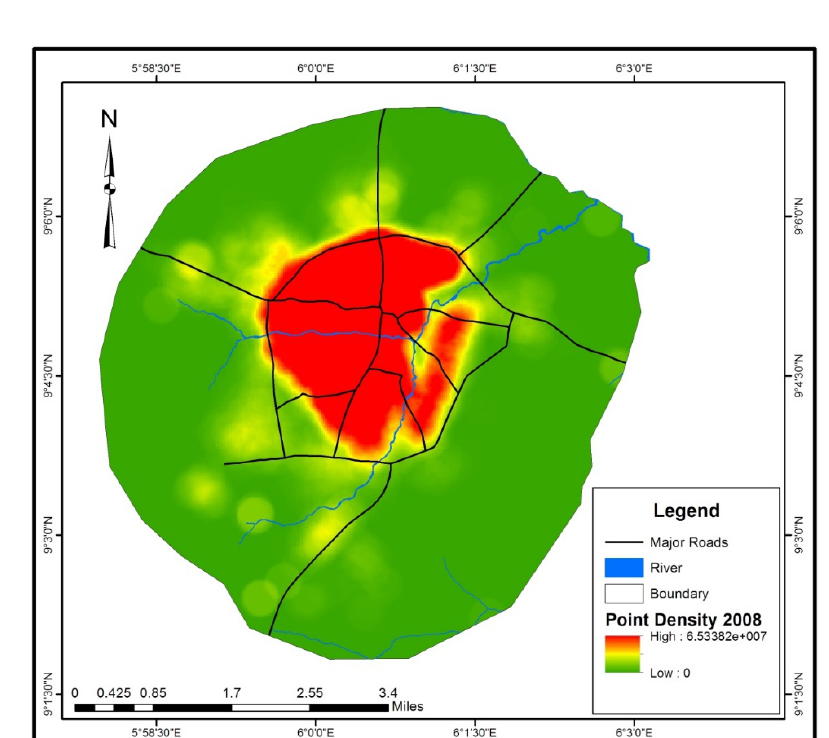
Fig. 3. Spatial pattern of residential density in the study area in 2008 (Developed by the authors, 2020).